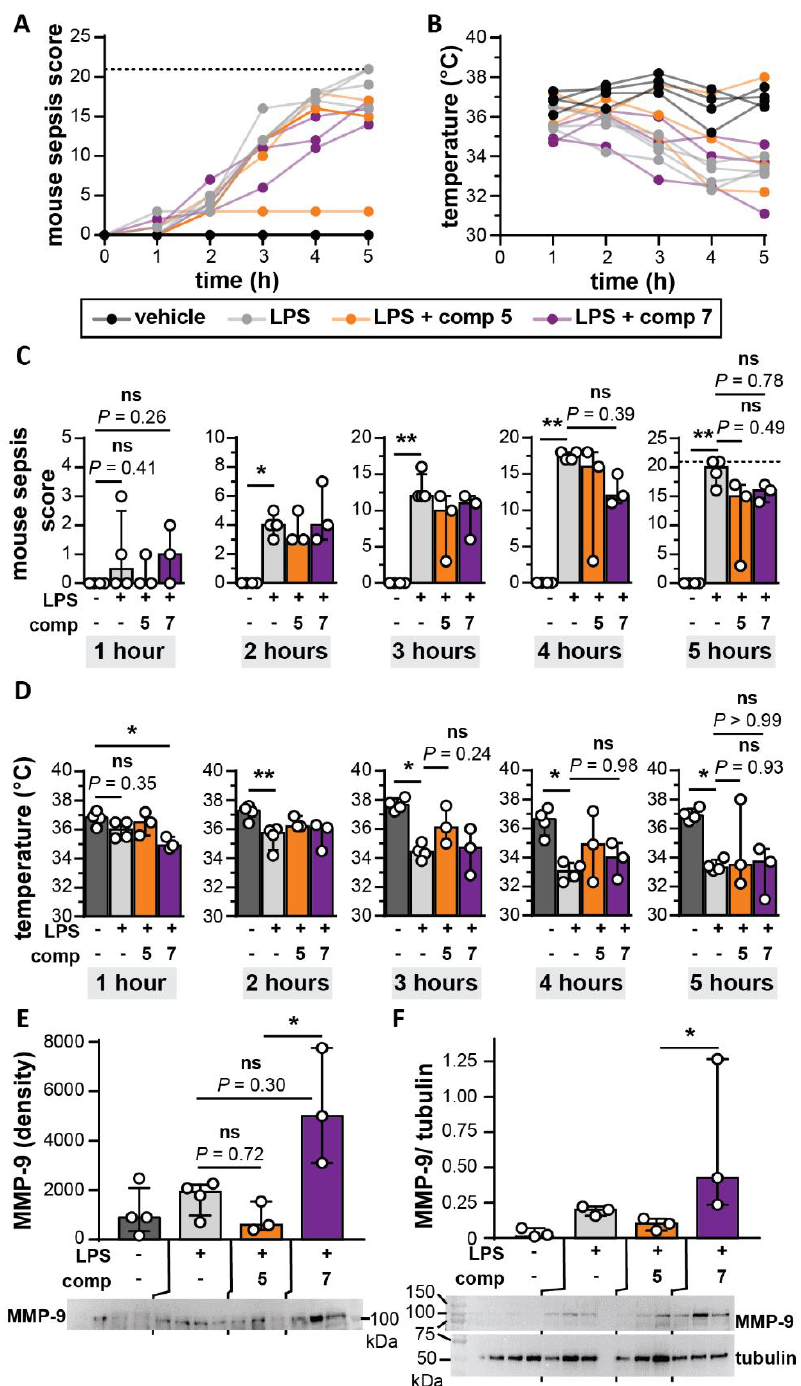
Figure 6. Endotoxemia mouse model. ( A ) Mouse sepsis score and ( B ) body temperature of control animals (vehicle, black), mice receiving 10 mg/kg LPS (grey), mice receiving 10 mg/kg LPS and 1 mg compound 5 (orange) and mice receiving 10 mg/kg LPS and 1 mg compound 7 (orange); ( C ) comparison of mouse sepsis score and ( D ) body temperature, each hour after LPS/compound injection. ( E ) Western-blot analysis of total MMP-9 found in mouse plasma, 5 h after LPS/compound administration. ( F ) Western-blot analysis of total MMP-9 found in mouse lungs, 5 h after LPS/compound administration and relative to a loading control (tubulin). Each data point represents a single mouse ( n = 3–4). * p < 0.05, ** p < 0.01. Bars represent median values. Full Western-blot images are available in Supplementary Figure S3. +/- signs indicate, respectively, the presence or absence of LPS (2 µg).